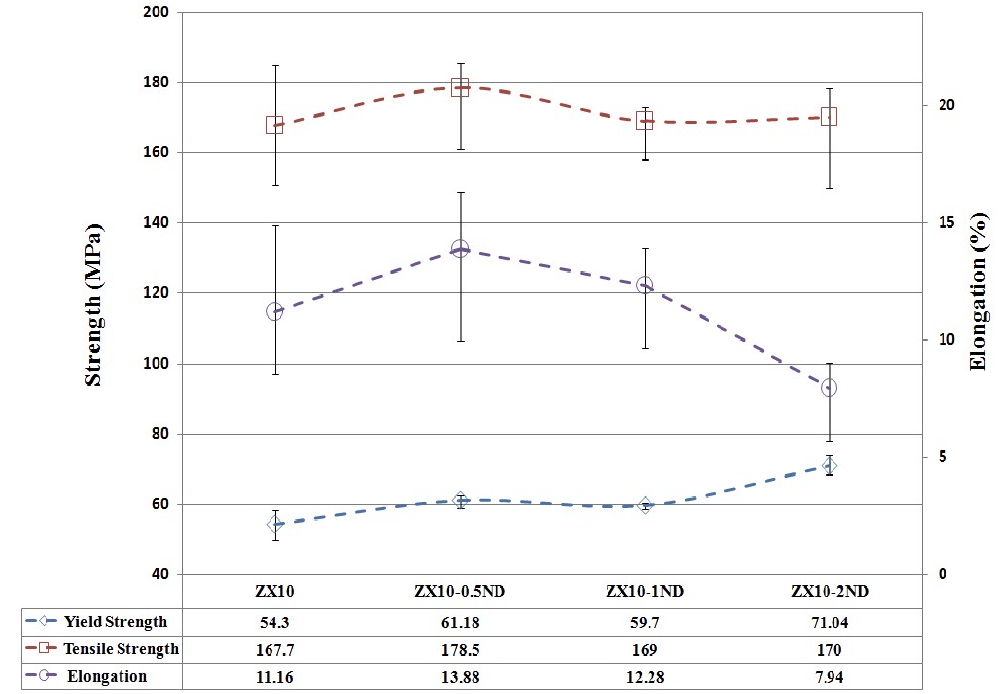
Figure 9. The yield strength, tensile strength, and elongation graphs of ZX10 alloy and nanocomposites at body temperature. Error bars represent full range of measured values.